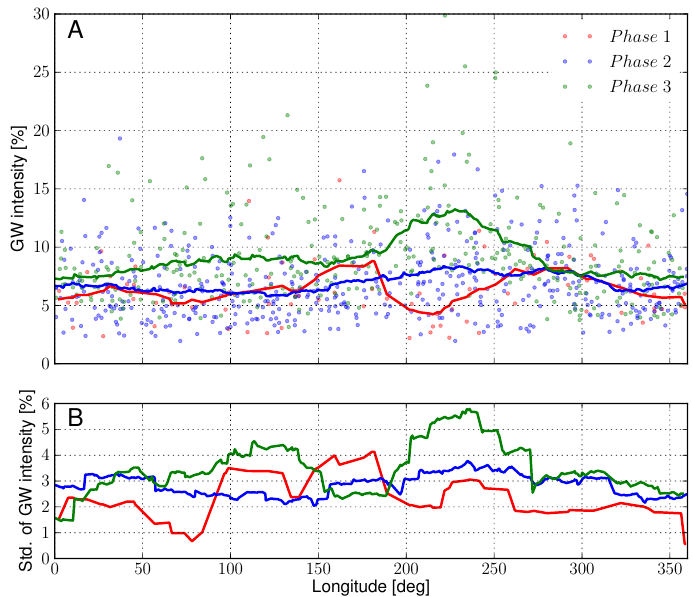
Figure 5. Relative density fluctuations as functions of longitude: ( A ) individual passes (dots, Phase 1: Passes 1–125; Phase 2: 134–629; Phase 3: 630–952) and the 20 ◦ longitude running mean (solid lines). ± ( B ) Root-mean-square (RMS) deviations with respect to the running mean as a measure of